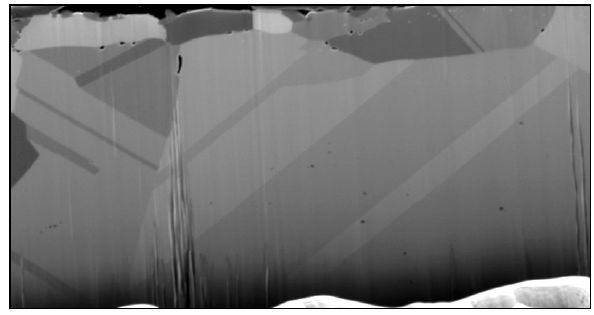
Figure 16. Cross-sectional SEM image of Inconel 625 sample after 100 h heating (10,000×).